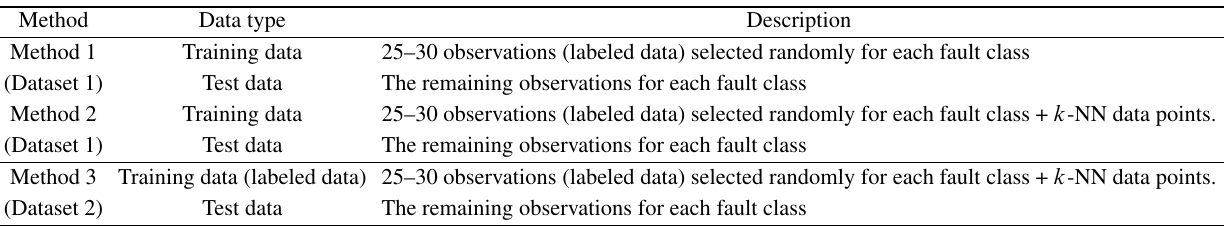
Table 7 Description of training and test datasets for the developed ML